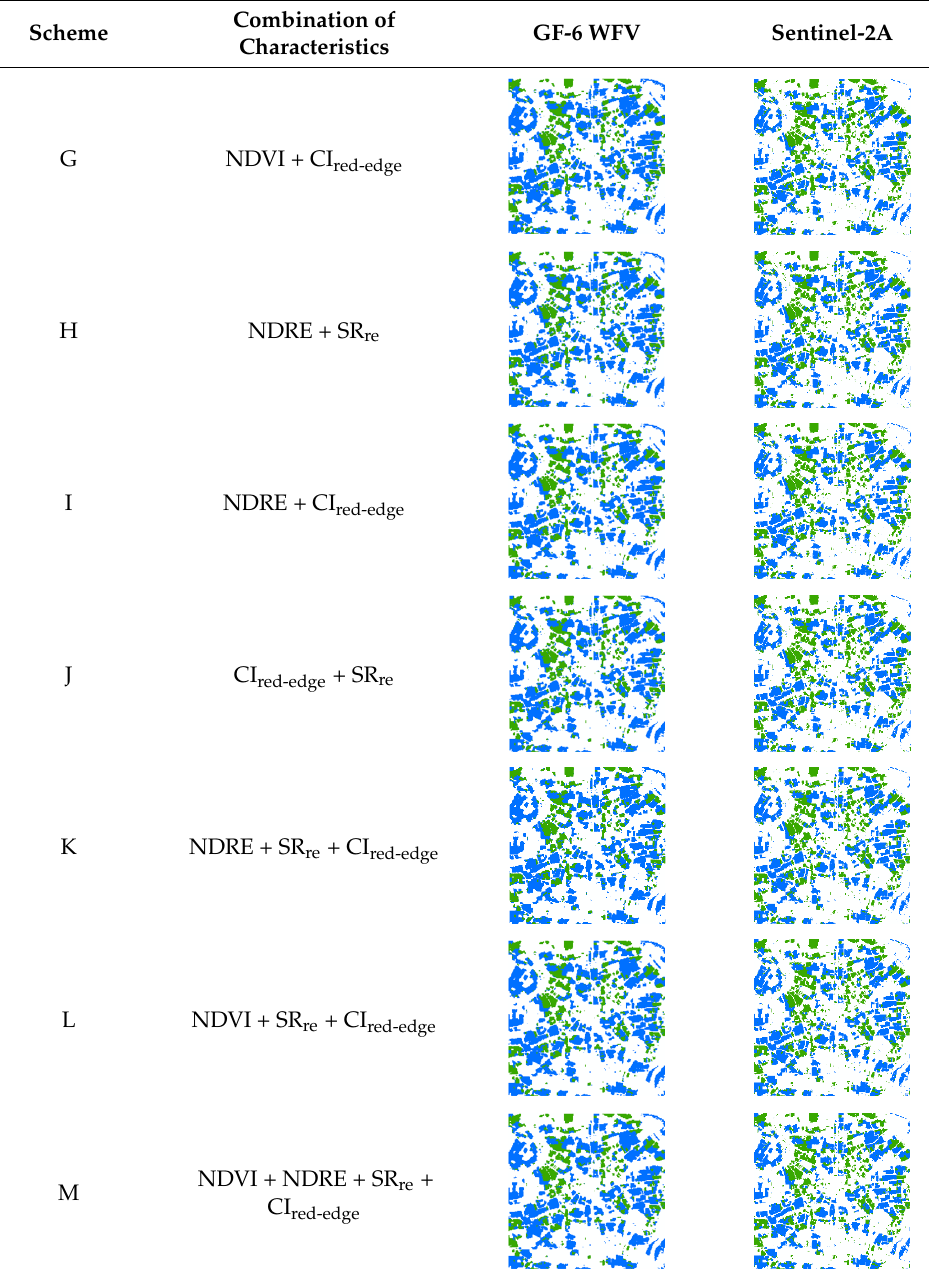
Table 11. Results of accuracy evaluation of GF-6 WFV and Sentinel-2A data with different combi- nations of spectral features.